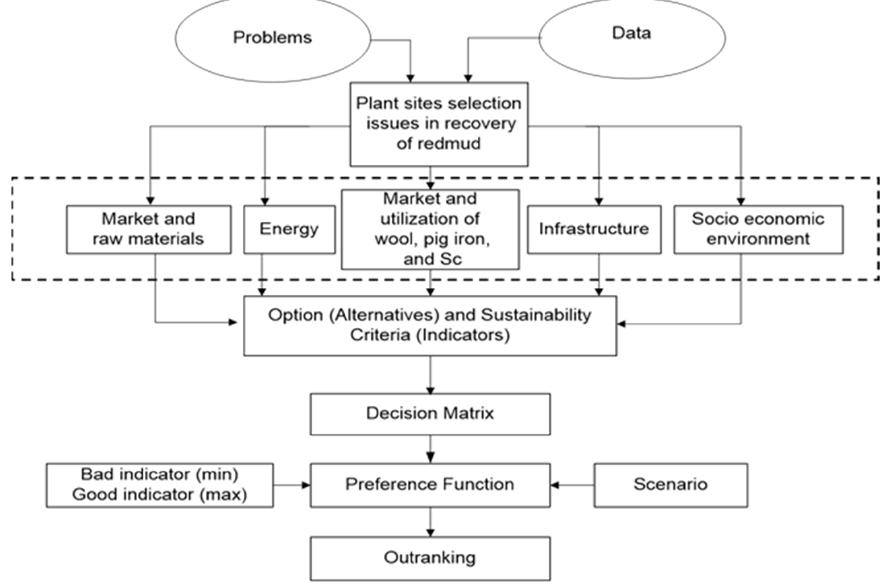
Figure 2. Technology roadmap of research.